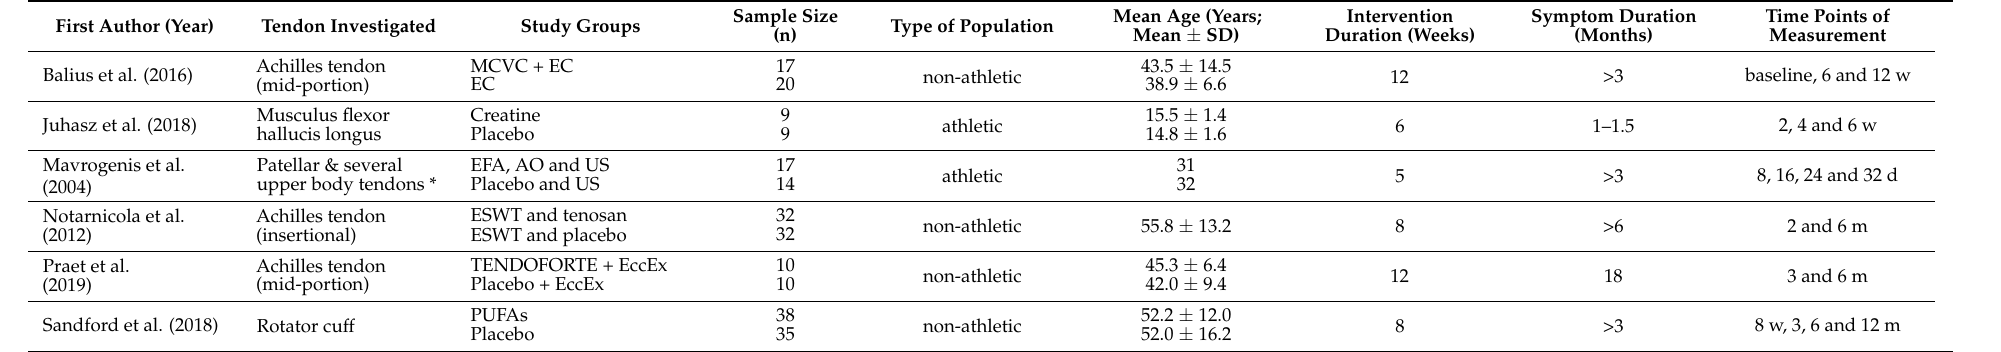
Table 1. Characteristics of included studies.